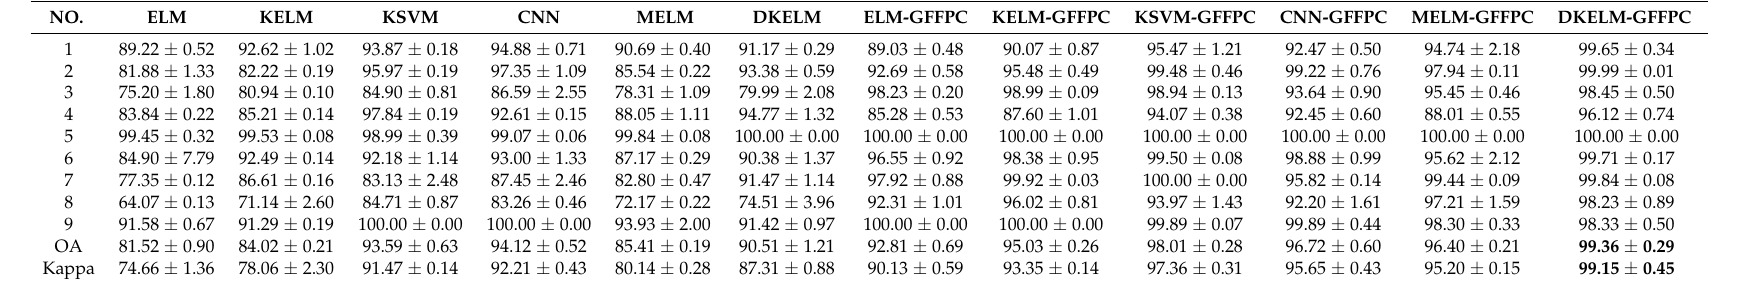
Table 6. Classification Accuracy(%) of the comparison and proposed algorithms in University of